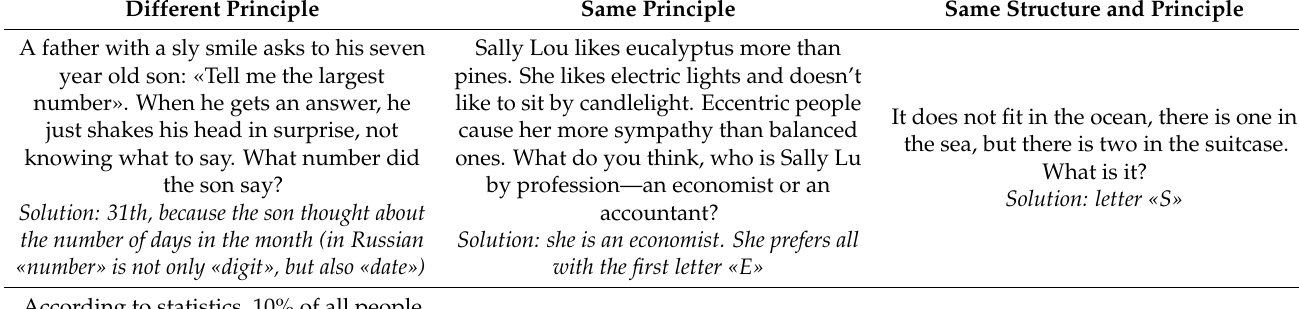
Table A1. Sets of problems in different experimental